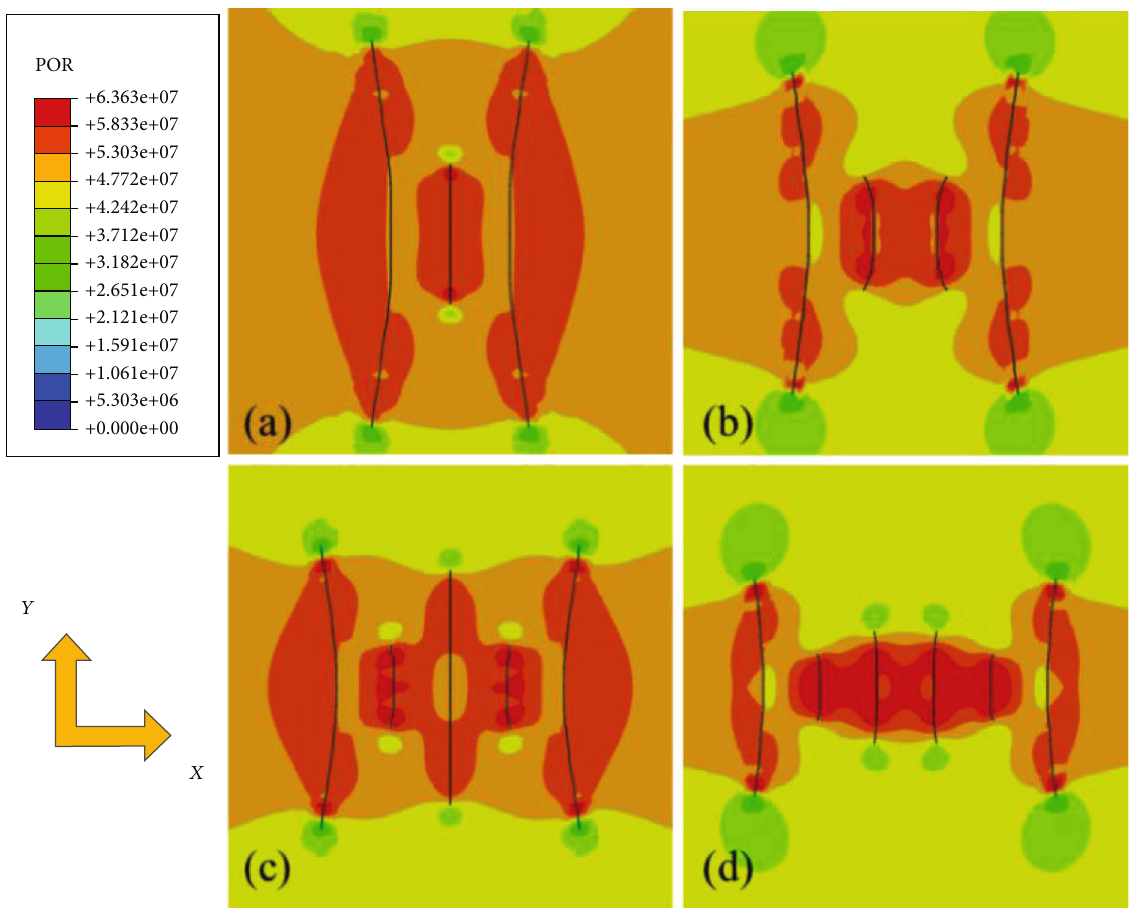
Figure 11: Fracture propagation results with di ff erent cluster number in a single